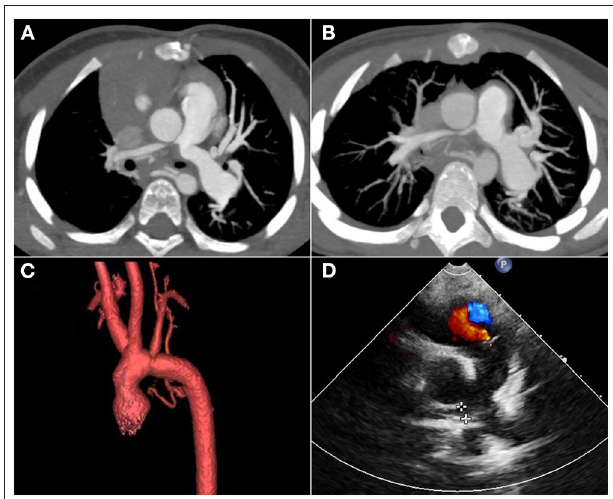
TABLE 1 | Characteristics of